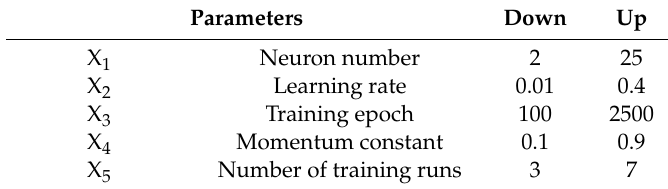
Table 18. Limits of input variables in the Neural Network model.